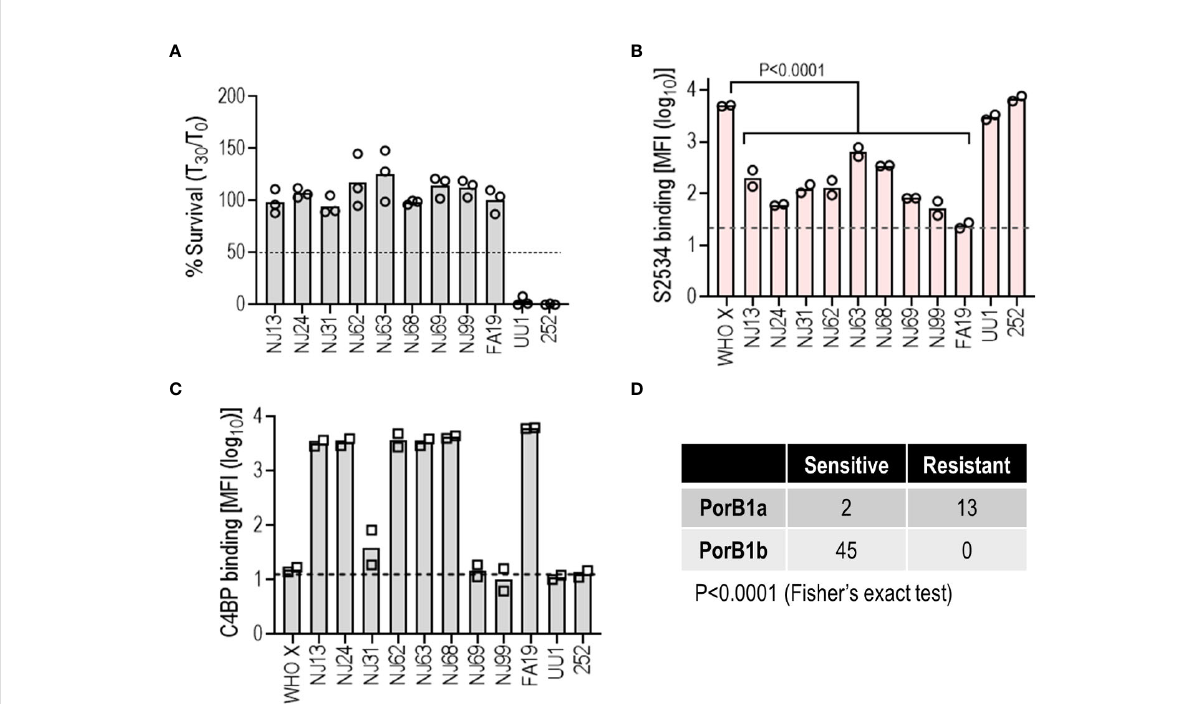
FIGURE 7 Low binding of S2534 (Fc3/FH*) limits its ef fi cacy against PorB1A N. gonorrhoeae . (A) Complement-dependent bactericidal activity of S2534 (Fc3/ FH*) against PorB1A gonococcal isolates. Ten additional PorB1A-expressing strains of N. gonorrhoeae (data with strain 252, used as a